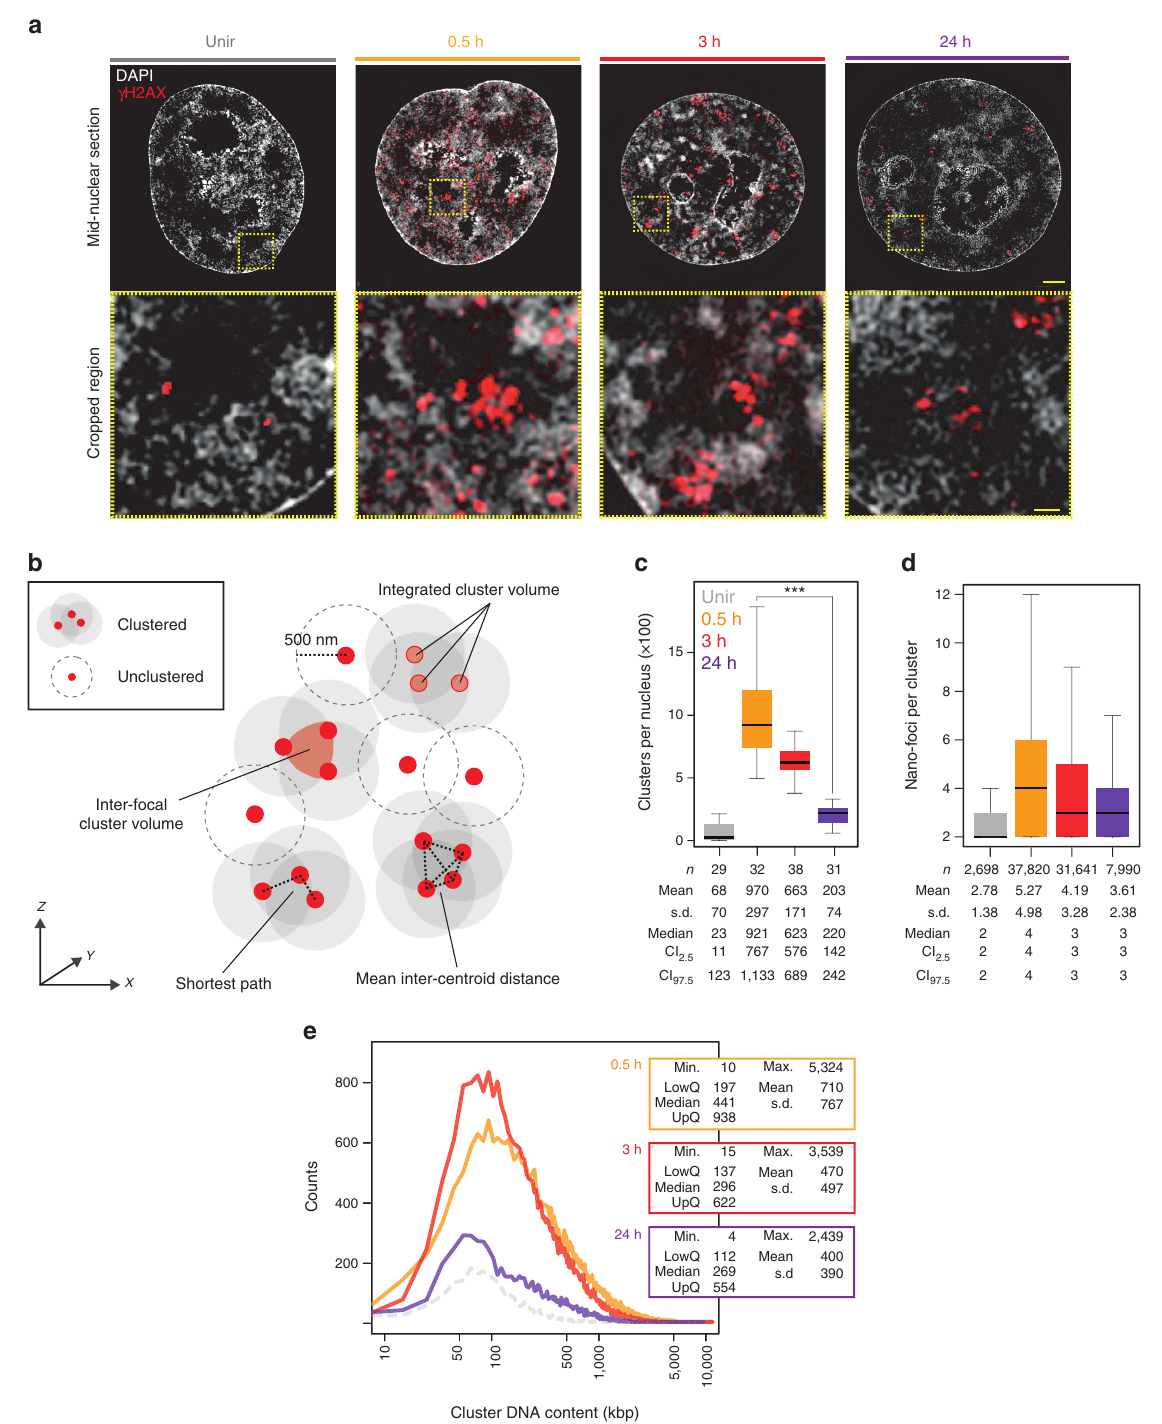
Figure 6 | Analysis of c H2AX nano-foci spatial clustering. ( a ) Exemplary 3D-SIM images of g H2AX immunofluorescence before and during DDR. Shown are the mid-nuclear section with DAPI and g H2AX signals, and magnified view from the yellow frame. Scale bars, 2 m m and 400nm for main micrographs and magnified regions, respectively. ( b ) Schematics of g H2AX 3D-clusters analysis. All centroids (red dots) within a sphere defined by a given cutoff radius (500nm in further analysis) are included in a cluster. For all nano-foci belonging to each given cluster, the sum of the volume of single nano-foci (integrated cluster volume), the volume delimited by the centroids (inter-focal volume), the shortest path connecting all centroids as well as the mean distance between centroids (mean inter-centroid distance) are computed (Supplementary Fig. 6C–F). ( c ) g H2AX 3D-clusters per nucleus. One-way ANOVA with Dunnett’s correction; *** P o 10 (cid:2) 3 . ( d ) g H2AX nano-foci per 3D-clusters. Kruskal–Wallis w 2 ¼ 1,926.3, df ¼ 3, P o 2.2 (cid:3) 10 (cid:2) 16 . ( e ) DNA content distributions of g H2AX 3D-clusters during DDR. The DNA content of each nano-focus belonging to a given cluster is summed. The dashed line depicts the distribution of g H2AX 3D-clusters before IR. Kruskal–Wallis w 2 ¼ 5,964.1, df ¼ 3, P o 2.2 (cid:3) 10 (cid:2) 16 . Statistics are presented as in Fig. 2. All boxes and whiskers are as in Fig. 1. n : number of analysed cells ( c ) or 3D-clusters ( d